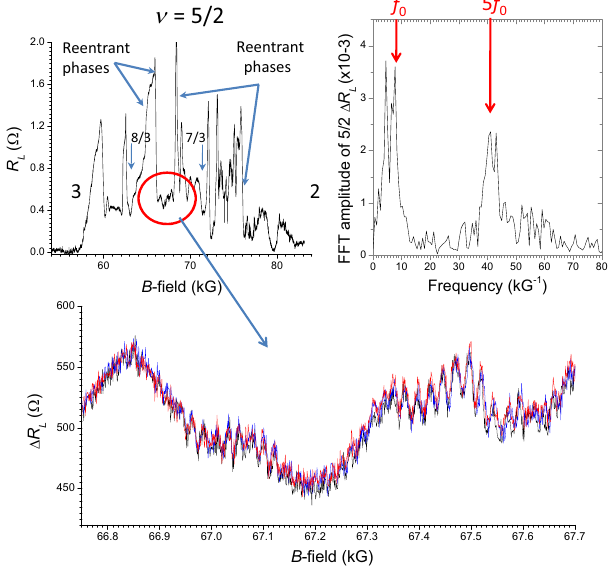
FIG. 10. Interference oscillations and their spectrum at ν ¼ 5 = 2 . Thetopleftpanelshowsthetraceof R fromfillingfactor ν ¼ 3 to2; L its enlargement in thevicinity of ν ¼ 5 = 2 (circled area) is shown in the bottom panel, with the corresponding FFT spectrum shown aboveintherightpanel. f 0 isthefrequencyofoscillationsobserved atintegerfillinginthesamesample.Thelowerpanelshowsthree B - fieldsweepsinasingledirection,demonstratingsignificantoverlap of the resistance oscillations. The frequency of rapid oscillations is approximately 5 f 0 shown in the power spectrum. Each trace is FIG. 11. Extracting power spectra in B -field sweeps and 60 minutes, so the total data collection time is 6 hours (the opposite interference spectra at ν ¼ 5 = 2 : (a) transport ( R ) through an L sweep direction is not shown). Sample 6, preparation 18, device interference device shown in Fig. 2, bottom micrograph (device type b, T ∼ 20 type b), between filling factors ν ¼ 2 and 3 in a high-mobility heterostructure without additional Al purification. The power spectrum is extracted from a B -field sweep as follows: The background resistance near ν ¼ 3 is subtracted, after which a FFT is applied to the residual oscillations, producing the power spectrum that shows a principal peak at roughly 6 kG − 1 , the frequency identified as f 0 whose value is closely matched at other integral filling factors. See also Fig. S5-1 in the Supplemental Material [34]. Temperature approximately 20 mK, sample 2, B Þ near preparation 2, device type b. (b) Power spectrum of R L ð ν ¼ 5 = 2 . The FFT window is bracketed in panel (a). After background subtraction and application of the FFT, four dom- inant peaks located near f 0 , 2 f 0 , 4 f 0 , and 6 f 0 can be discerned. Here, f 0 is the frequency of the Aharonov-Bohm oscillations in the integer quantum Hall state [panel (a)], and marked in panels (a) and (b) by the solid red vertical line. Solid green lines in panel (b) indicate multiples of that frequency with the shaded area around them indicating the potential error margins stemming from the error of (cid:3) 1 = 8 kG − 1 in determining f 0 . In the meantime, the dashed lines indicate multiples of the actual frequency of the first peak in panel (b).